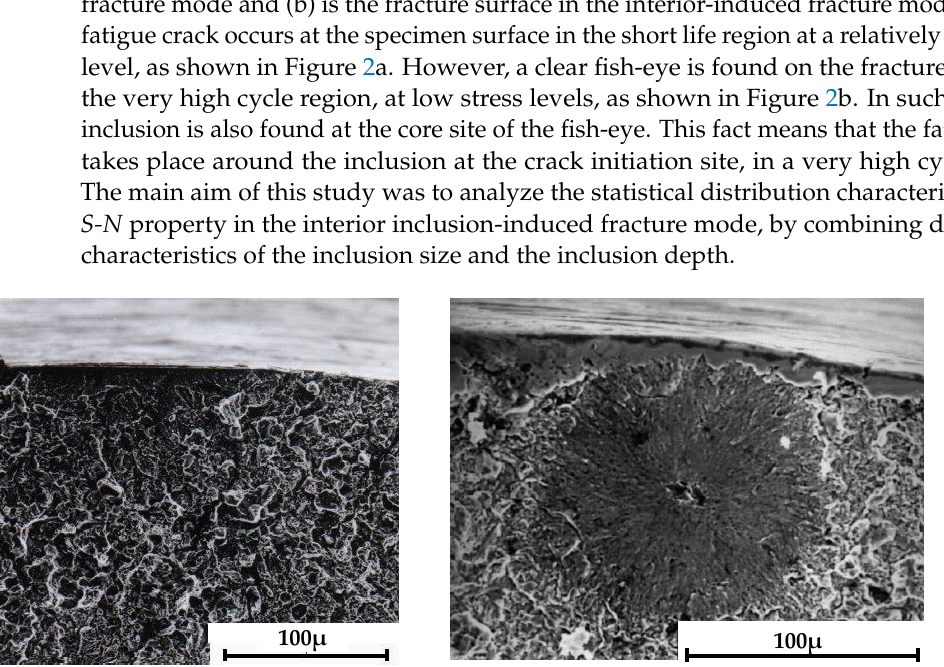
Figure 1. Rotating bending S-N characteristics of bearing steel in very high cycle regime.